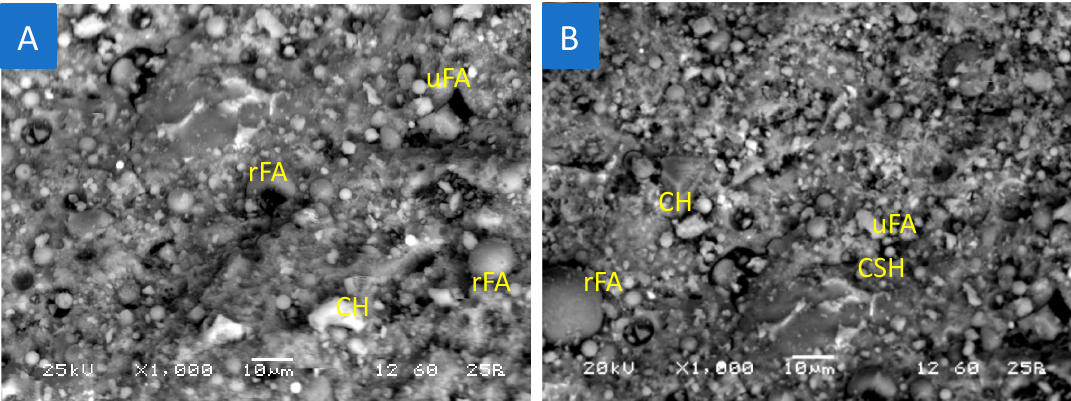
Figure 25. BSC micrograph of PC43LS20FA37 at 28D at a ) 1000× magnification and (B) 1000× magnification.